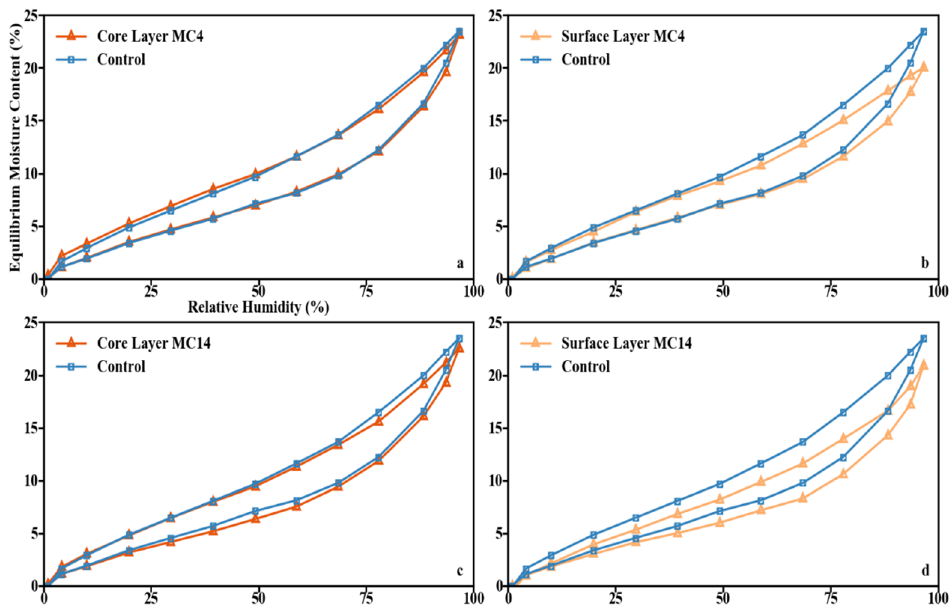
Figure 6. Sorption isotherm comparison between the control sample and: ( a ) core layer of sample MC4; ( b ) surface layer of sample MC4; ( c ) core layer of sample MC14; ( d ) surface layer of sample MC14.